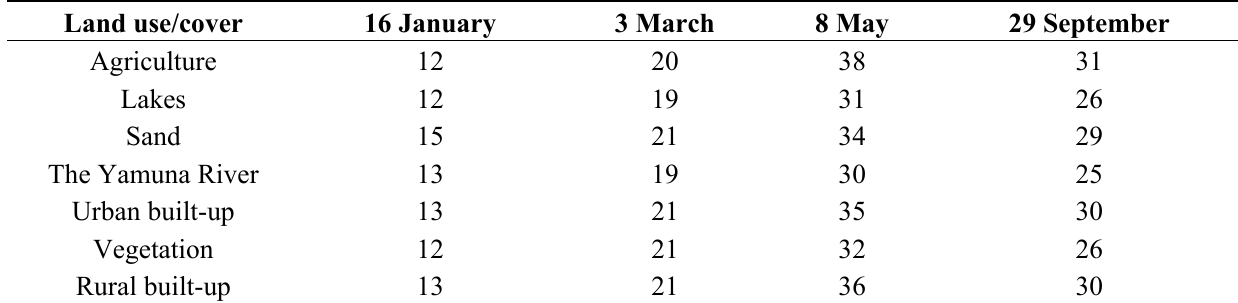
Table 3. Seasonwise average temperature across the land use/cover types. Source: Calculated from Landsat TM 5 thermal band. Land